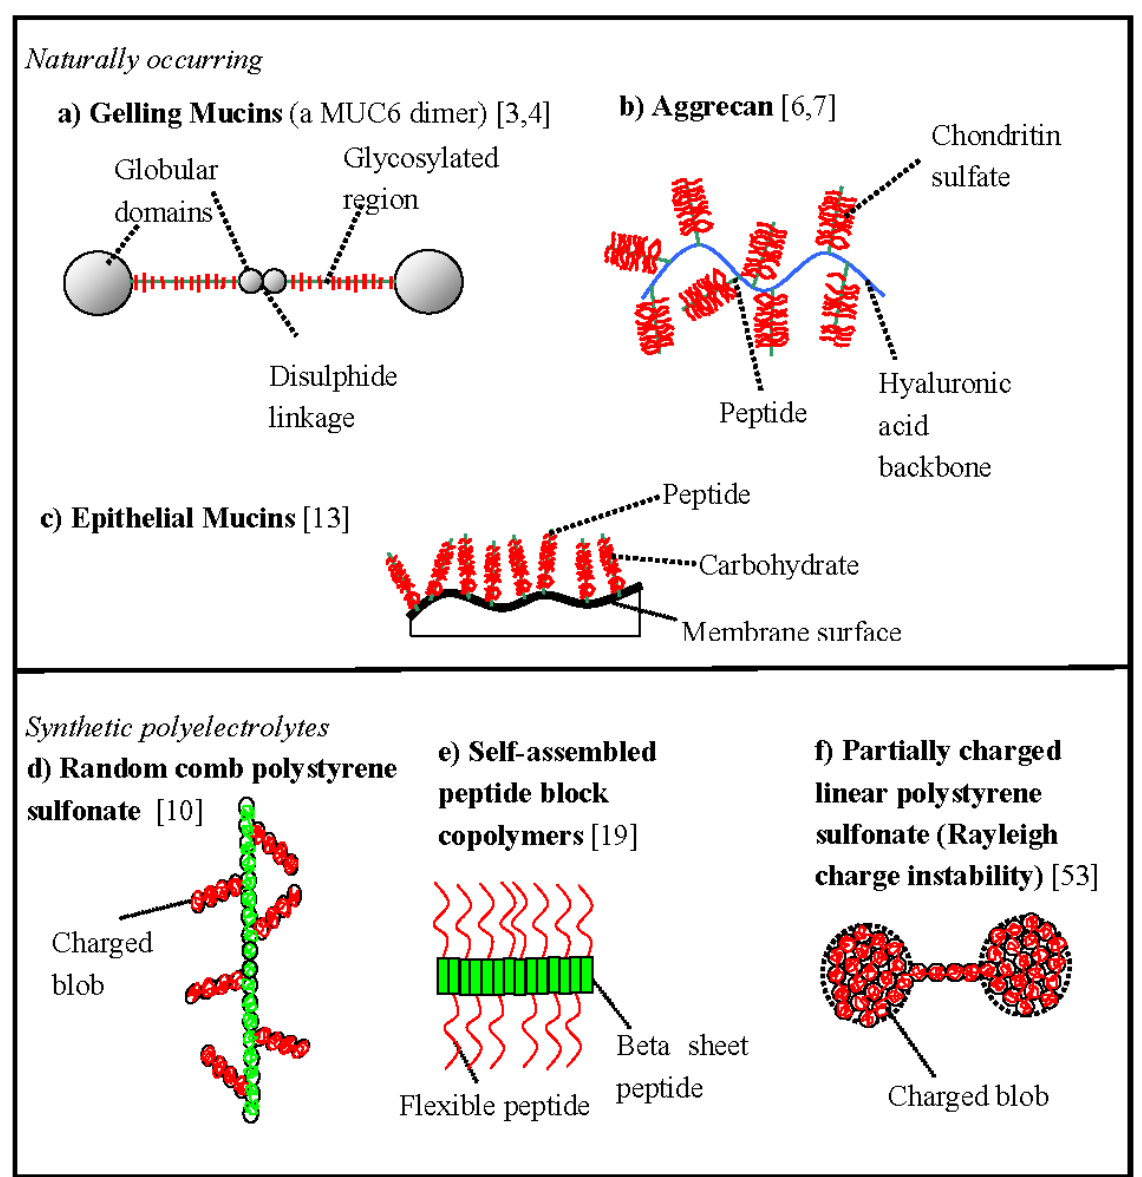
The morphology of some schematic comb biopolymers and related polyelectrolyte structures. (a) Gelling mucins, e.g., porcine MUC6 [11]. (b) Proteoglycans, e.g., bovine aggrecan [6,7]. (c) Epithelial mucins [13]. (d) Synthetic flexible comb polyelectrolytes, e.g., polystyrene sulfonate [10]. (e) Synthetic self-assembled